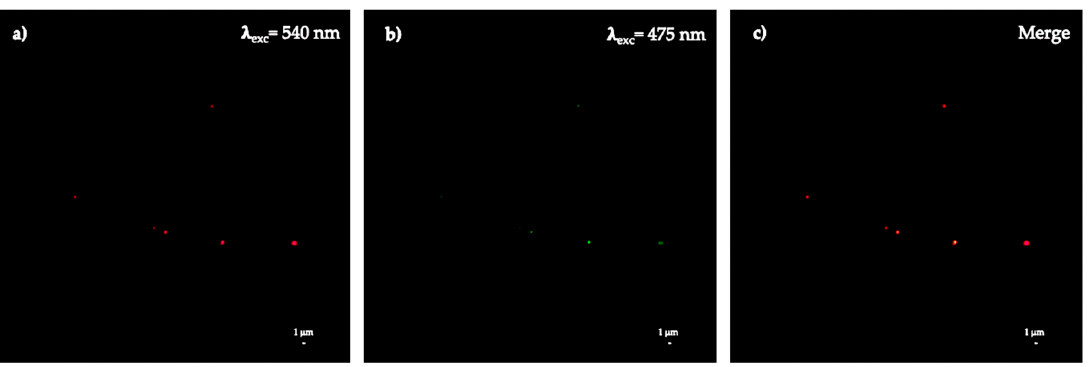
Figure 4. Wide-field fluorescence image of ( a ) a-TiO 2 NPs labeled with ATTO 550-NH2 ester; ( b ) lipid shell labeled with 1% of DiOC 18 ; ( c ) the merged channels showing complete colocalization. Scale bar: 1 µm and mass ratio NPs:Lipids (1:5). Table 1. Conjugation yield in percentage obtained for both mass ratio tested of Nanoparticles (NPs):Phospholipids (1:5 and 1.5:5).